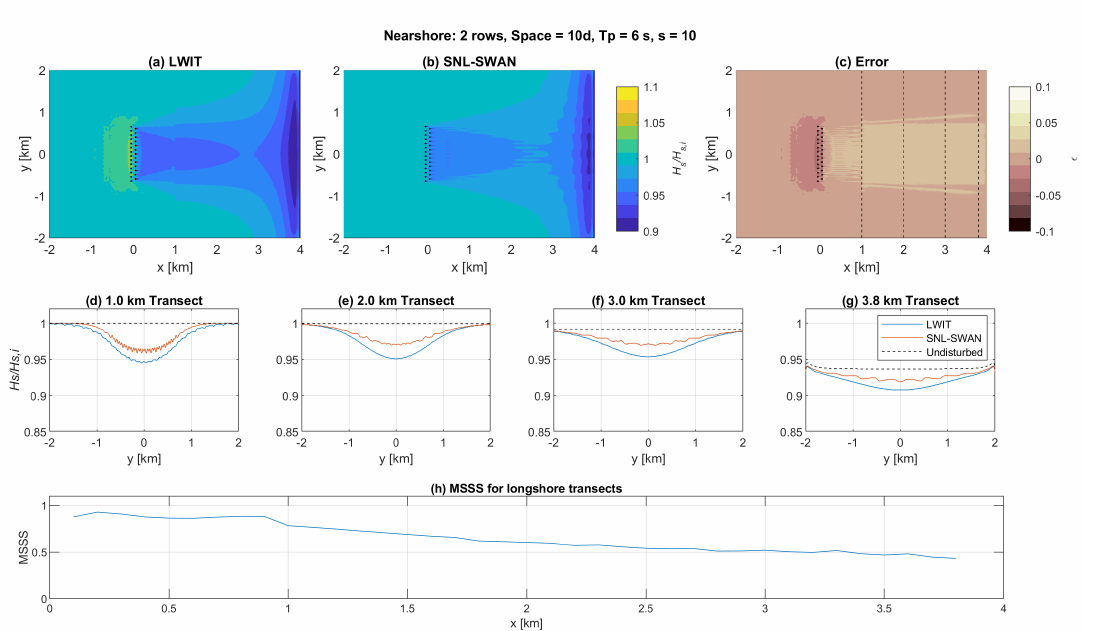
Figure 7. Example result of the comparison between SNL-SWAN and